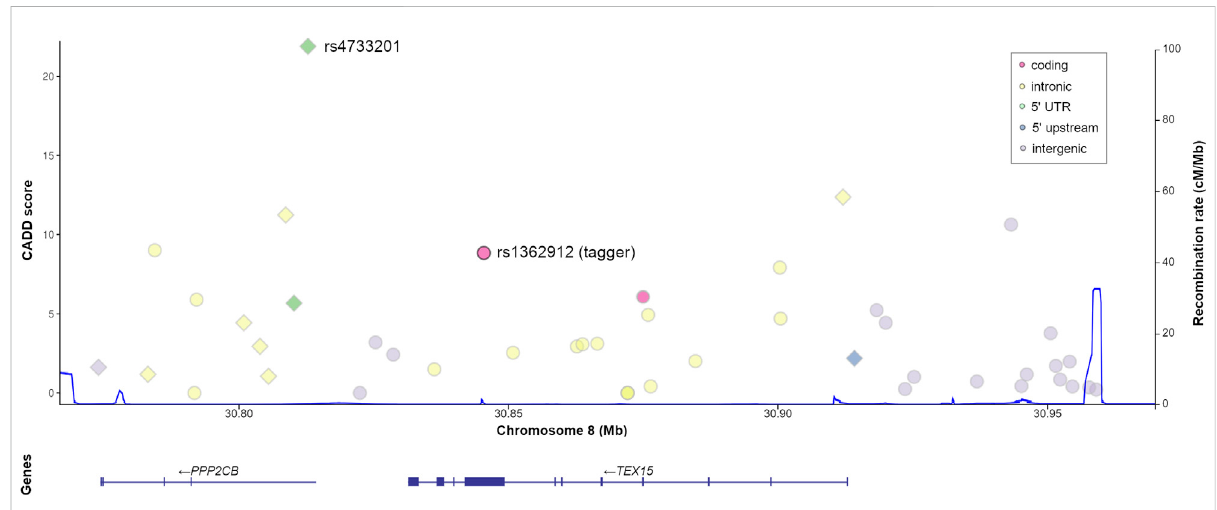
FIGURE 1 Genomic context and predicted functional relevance of the proxy variants tagged by TEX15 -rs1362912. Both the CADD scores of each variant (left x -axis)andtherecombinationrateoftheregion(right x axis,blueline)aredisplayed.Variantswithfunctionalannotationsintestisarerepresented as